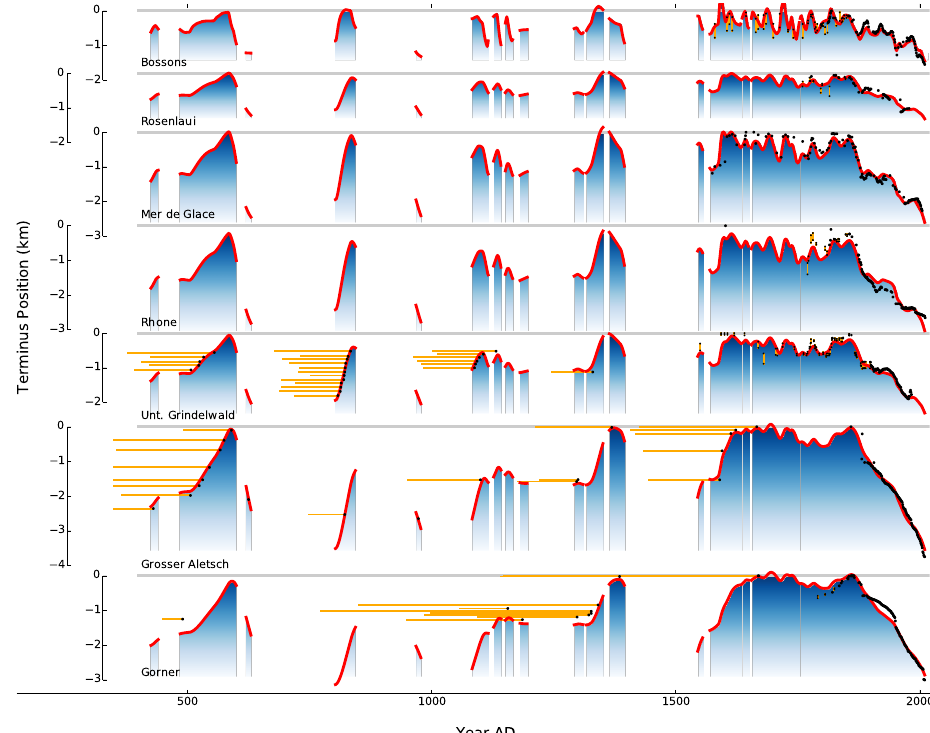
Fig. 1. Comparison of modeled and measured terminus position histories of seven glaciers. Results from the best-matching model run are shown with a red line, which is hidden in intervals without length constraints. Black dots mark individual terminus position measurements, orange horizontal lines represent the life spans of trees killed by advancing glaciers (Table 1 for data